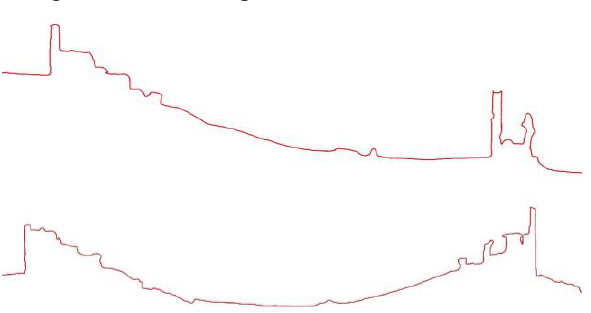
Figure 13. 3D model automatically generated surface sections.